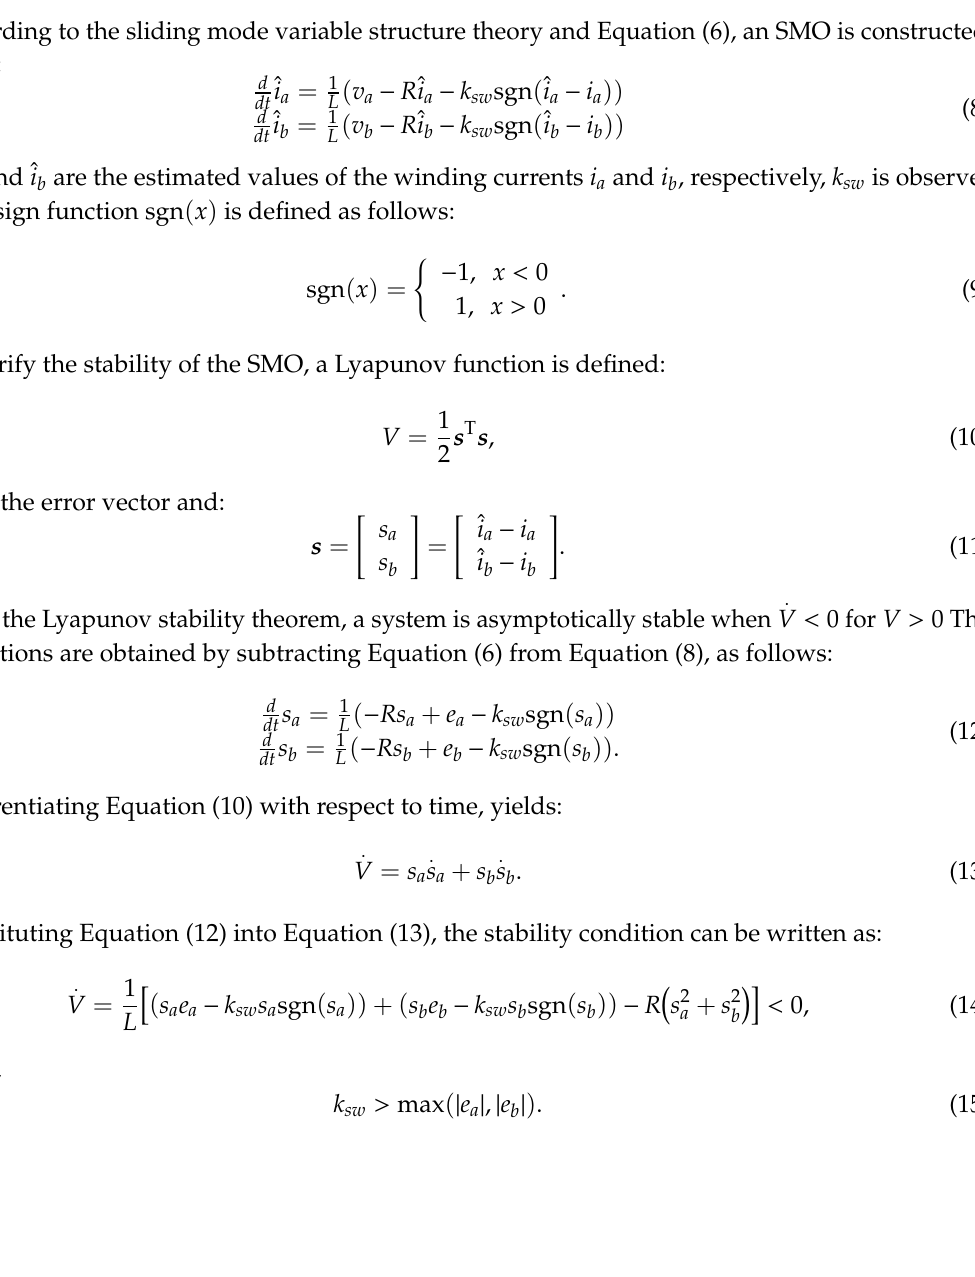
Figure 3. Block diagram of the sliding mode observer (SMO) based speed and position estimator.